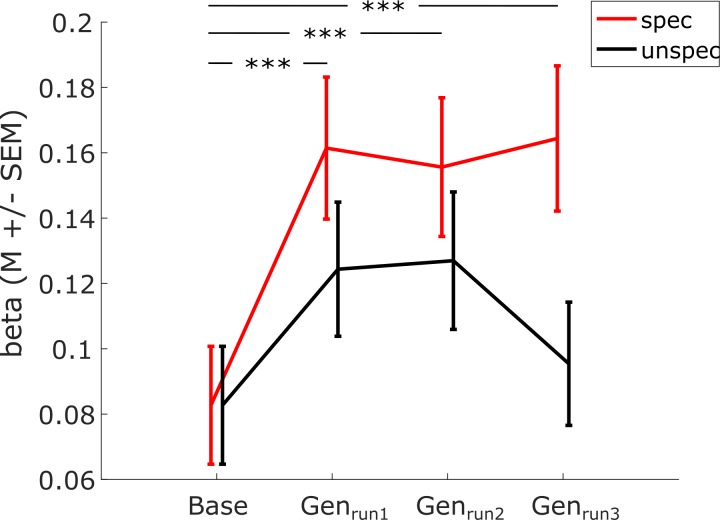
Model parameters for Adversity Gradient Model across subsequent test runs.Beta estimates from the Adversity Gradient model of the specific and unspecific component when modeling data from the three generalization phase (‘Gen’) runs independently. The model estimates were computed on single subject dissimilarity matrices (cf. Figure 1). Shown is the average weight for the whole group, error bars indicate the SEM across subjects. Asterisks indicate significant differences of beta estimates of single generalization run compared to baseline phase (paired t-tests, ***: pcorr <0.001), showing that the unspecific component did not increase significantly from baseline to any of the generalization runs. Results of a repeated measures ANOVA (experimental run ×predictor (spec/unspec)): main effect of predictor (F(1, 73)=3.8, p=0.056, interaction of predictor (spec/unspec) with experimental run F(1,73) = 2.6, p=0.054).